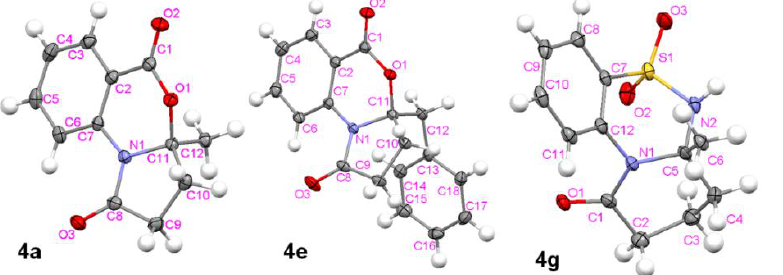
Figure 4. Molecular structure of benzopyrrolo[1,3]oxazine-1,5-diones 4a and 4e and benzopyrido[1,2,4]thiadiazinone-5,5-dioxide 4g with the atomic numbering scheme. Thermal ellipsoids are given at the 50% probability level.